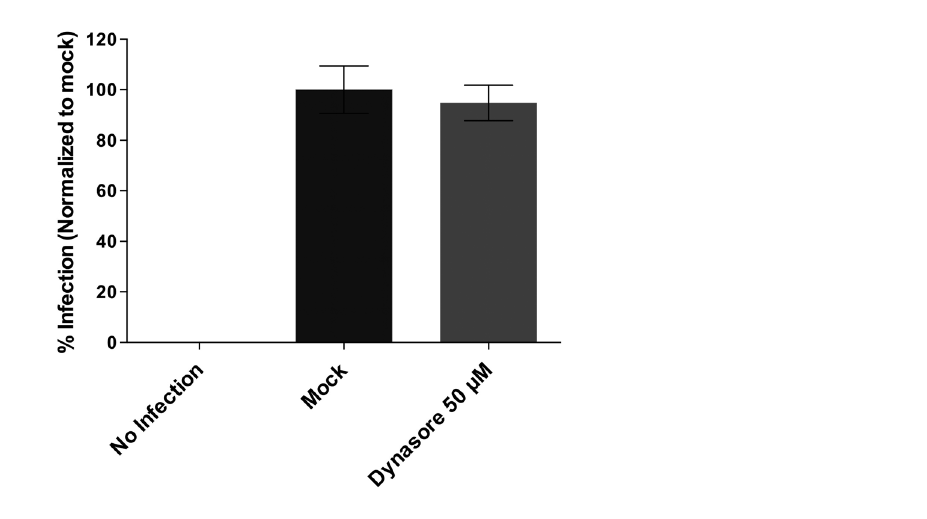
Figure 4. IPNV infection is independent of dynamin. CHSE-214 cells were propagated at 70–80% confluence in 24-well plates with round glass coverslips and pre incubated with 0 or 50 µ M dynasore for 1 h at 20 °C. IPNV was inoculated at an MOI of 1 and led the infection proceed for 12 h at 20 °C in absence (mock) or presence of the inhibitor. Cells were processed by indirect immunofluorescence (IFI) for VP2/VP3 IPNV proteins. Imaging of fixed slides was performed with an Olympus Spinning Disk IX81 microscope, and 250 cells were counted at each condition. Number of VP2/VP3-expressing cells is shown as a percentage, normalized to mock